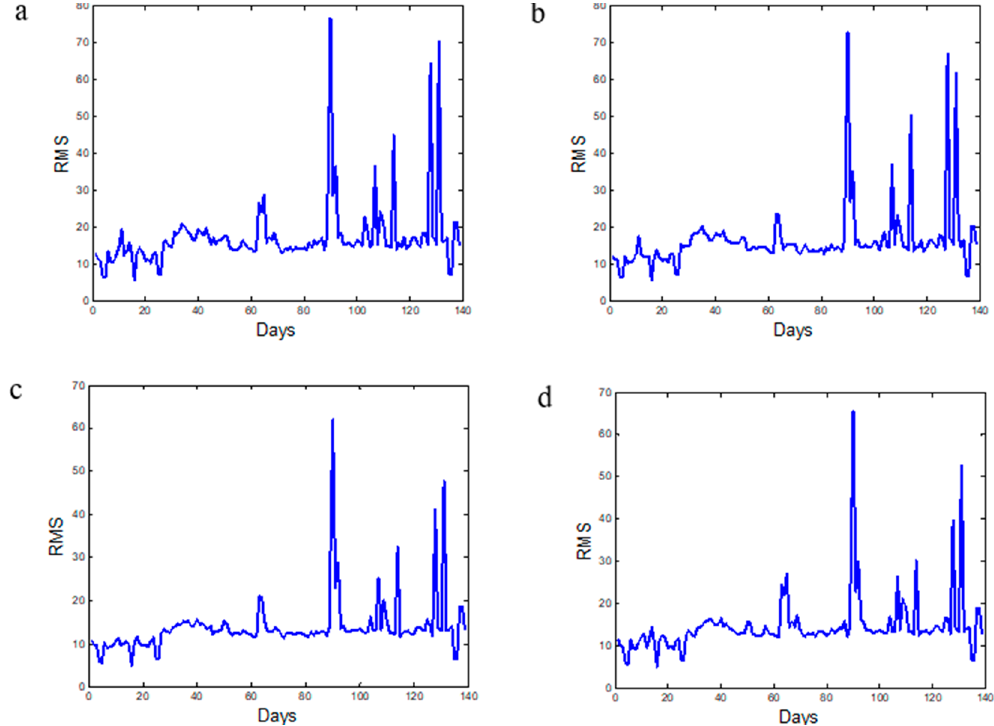
Figure 9. RMS feature calculated from MM operators for 0.9 T (T = 1/BPFO): ( a ) erosion; ( b ) dilation; ( c ) closing and ( d ) opening.